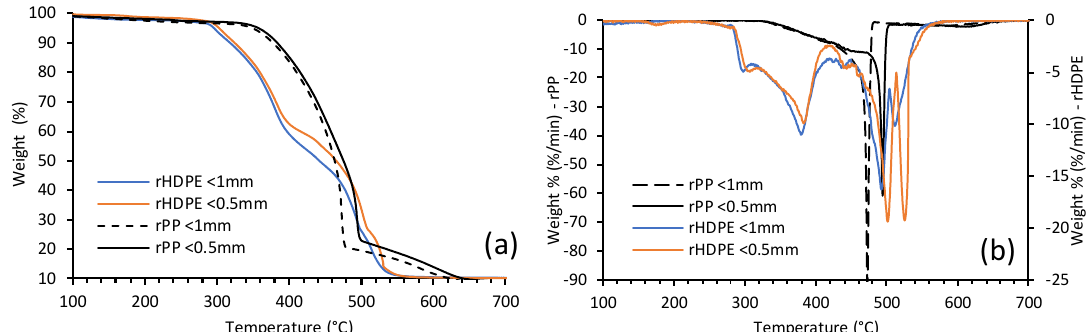
Figure 3. ( a ) Thermogravimetric analysis (TGA) and ( b ) differential thermogravimetric (DTG) curves for rice hull polyolefin composites. Table 3. Thermal degradation behavior of polyolefin composites.